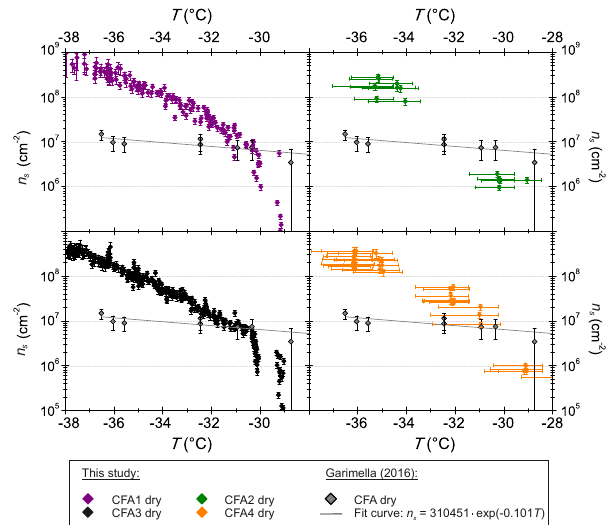
Figure 3. n s from SPIN measurements with dry-generated 300nm CFA particles. Horizontal error bars are omitted in the CFA1 and CFA3 panels for greater clarity but are comparable to the values shown in the CFA2 and CFA4 panels. Measurements with CFA samples from the USA (Garimella, 2016) are included for compar-